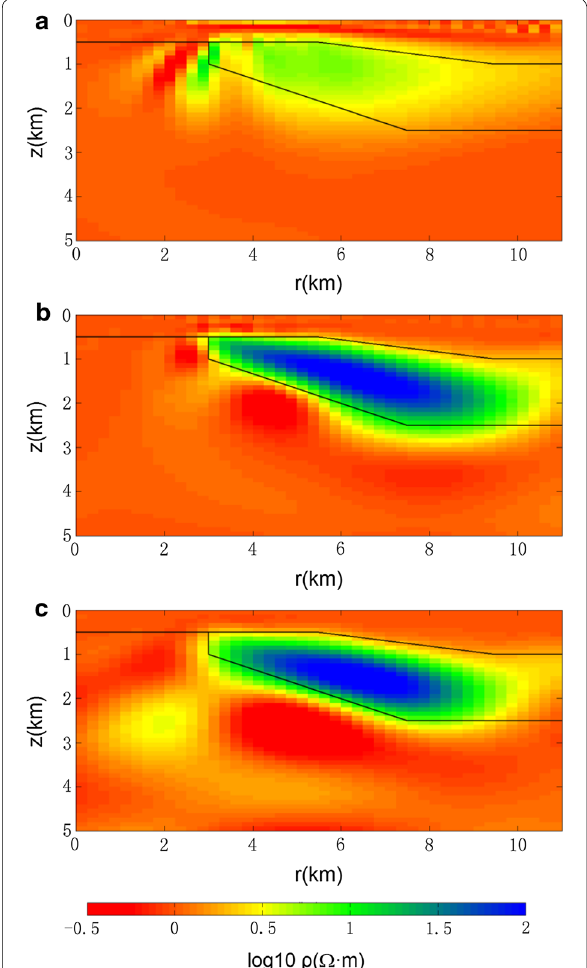
Fig. 9 Synthetic inversion results for the 2D resistive model (Fig. 6a) using different stabilizing functionals a MM, b FM, and c SM. Color scale is the same as Fig. 6a